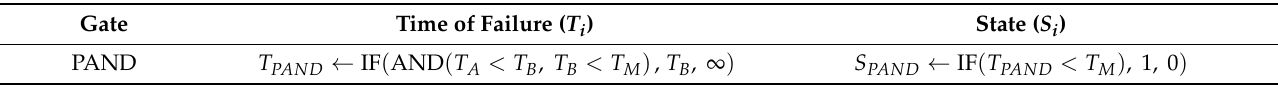
state is denoted as 1. Table 2. Logical expression for deriving the output of a PAND